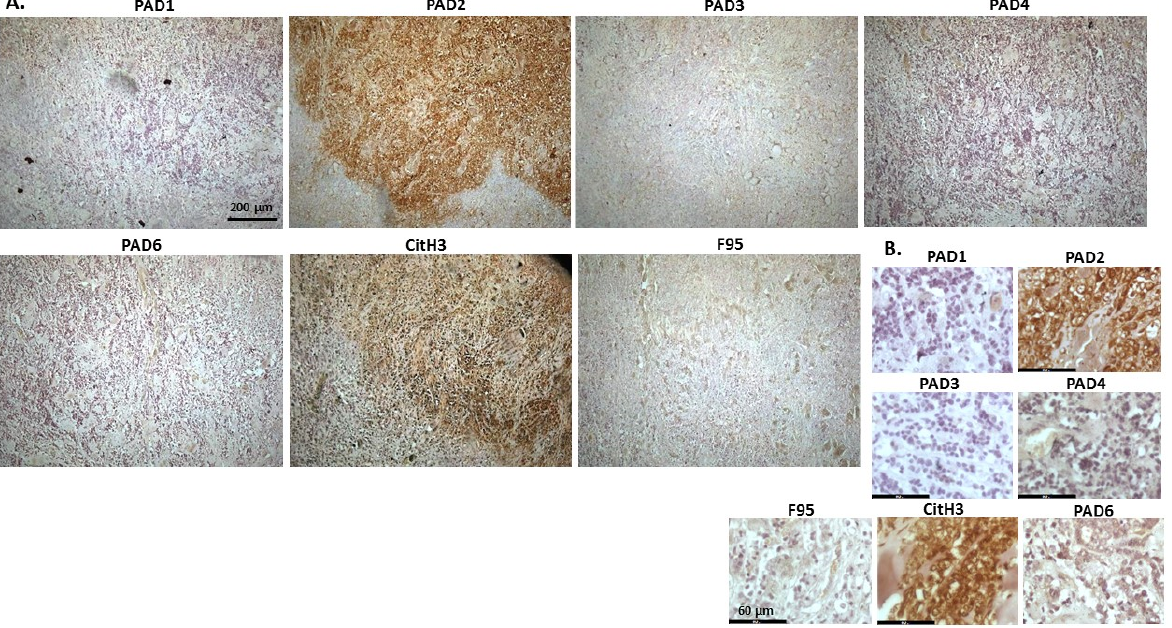
Figure 5. Sheep (two-year old ewe), malignant round cell tumour in skin. Origin of this highly ma- lignant tumour is unknown. ( A ) Overview images for PAD1, 2, 3, 4, 6, CitH3, and F95 stainings of serial tissue sections; scale bar represents 200 μ m for all images; 10× objective. ( B ) Higher magni- fication shown for each staining from the images in ( A ); scale bar represents 60 μ m for all images; 40× objective.